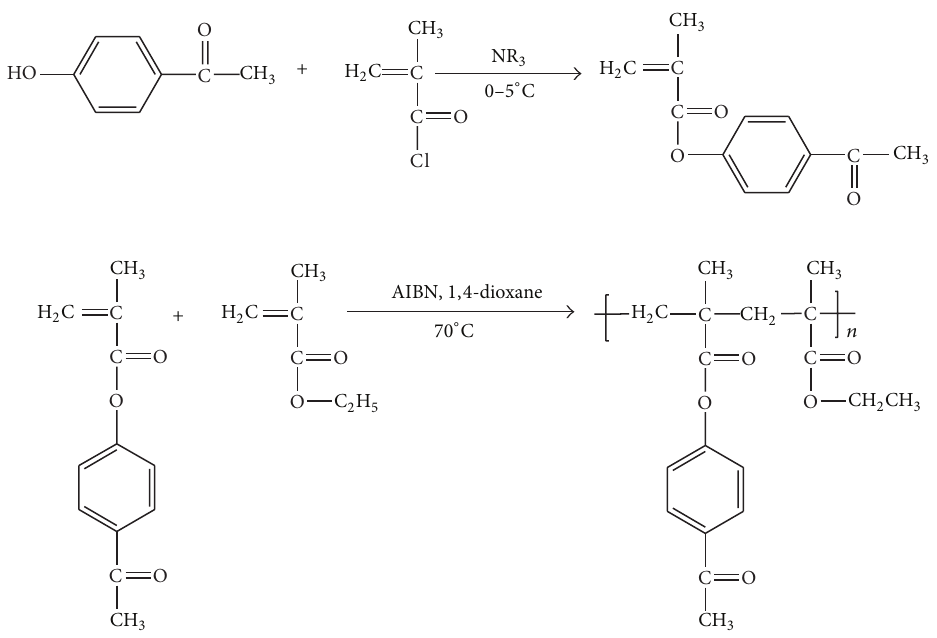
Scheme 1: Synthesis of APMA and